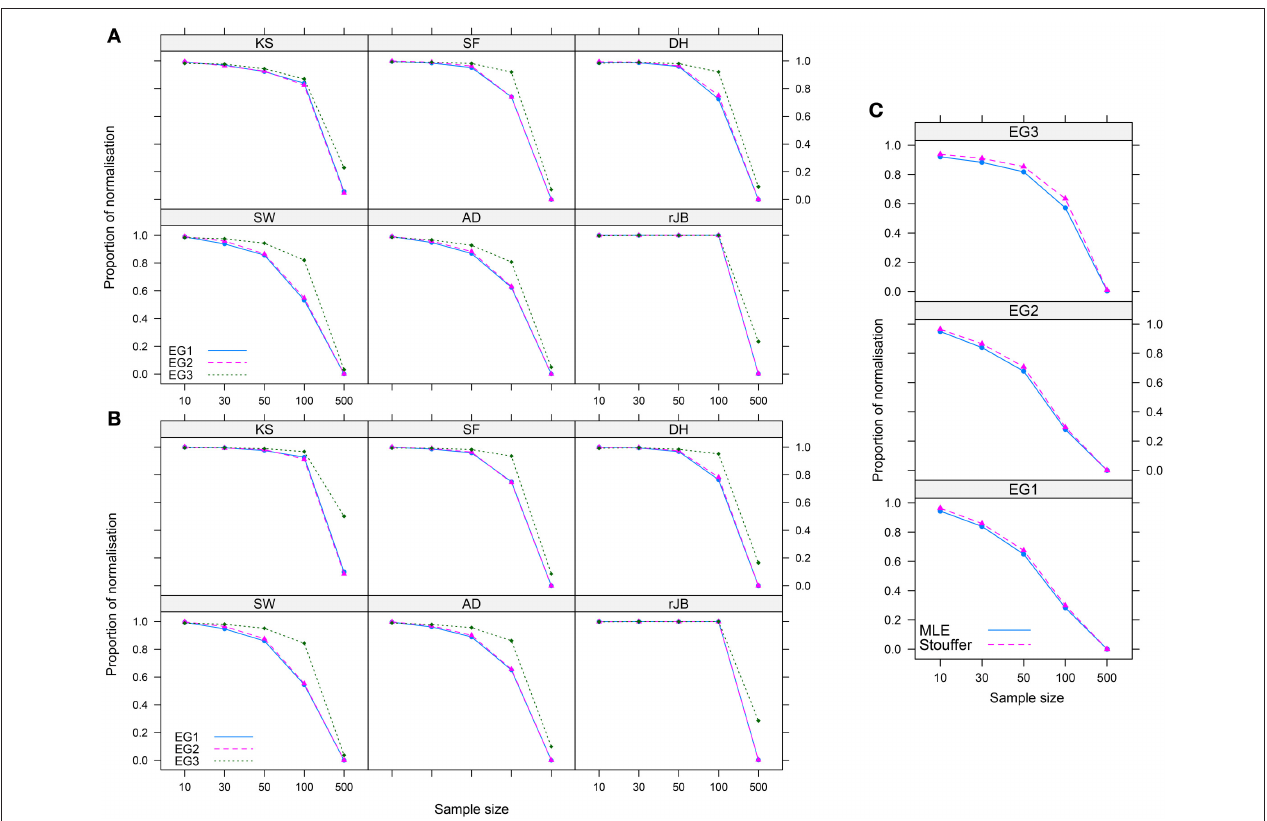
FIGURE 3 | Proportion of normalization achieved by the (A) MLE and (B) p -value-based approaches for six normality tests in three Ex-Gaussian distributions, and (C) all p -values of the normality tests are combined using Stouffer’s method. Abbreviations as in Figure 2